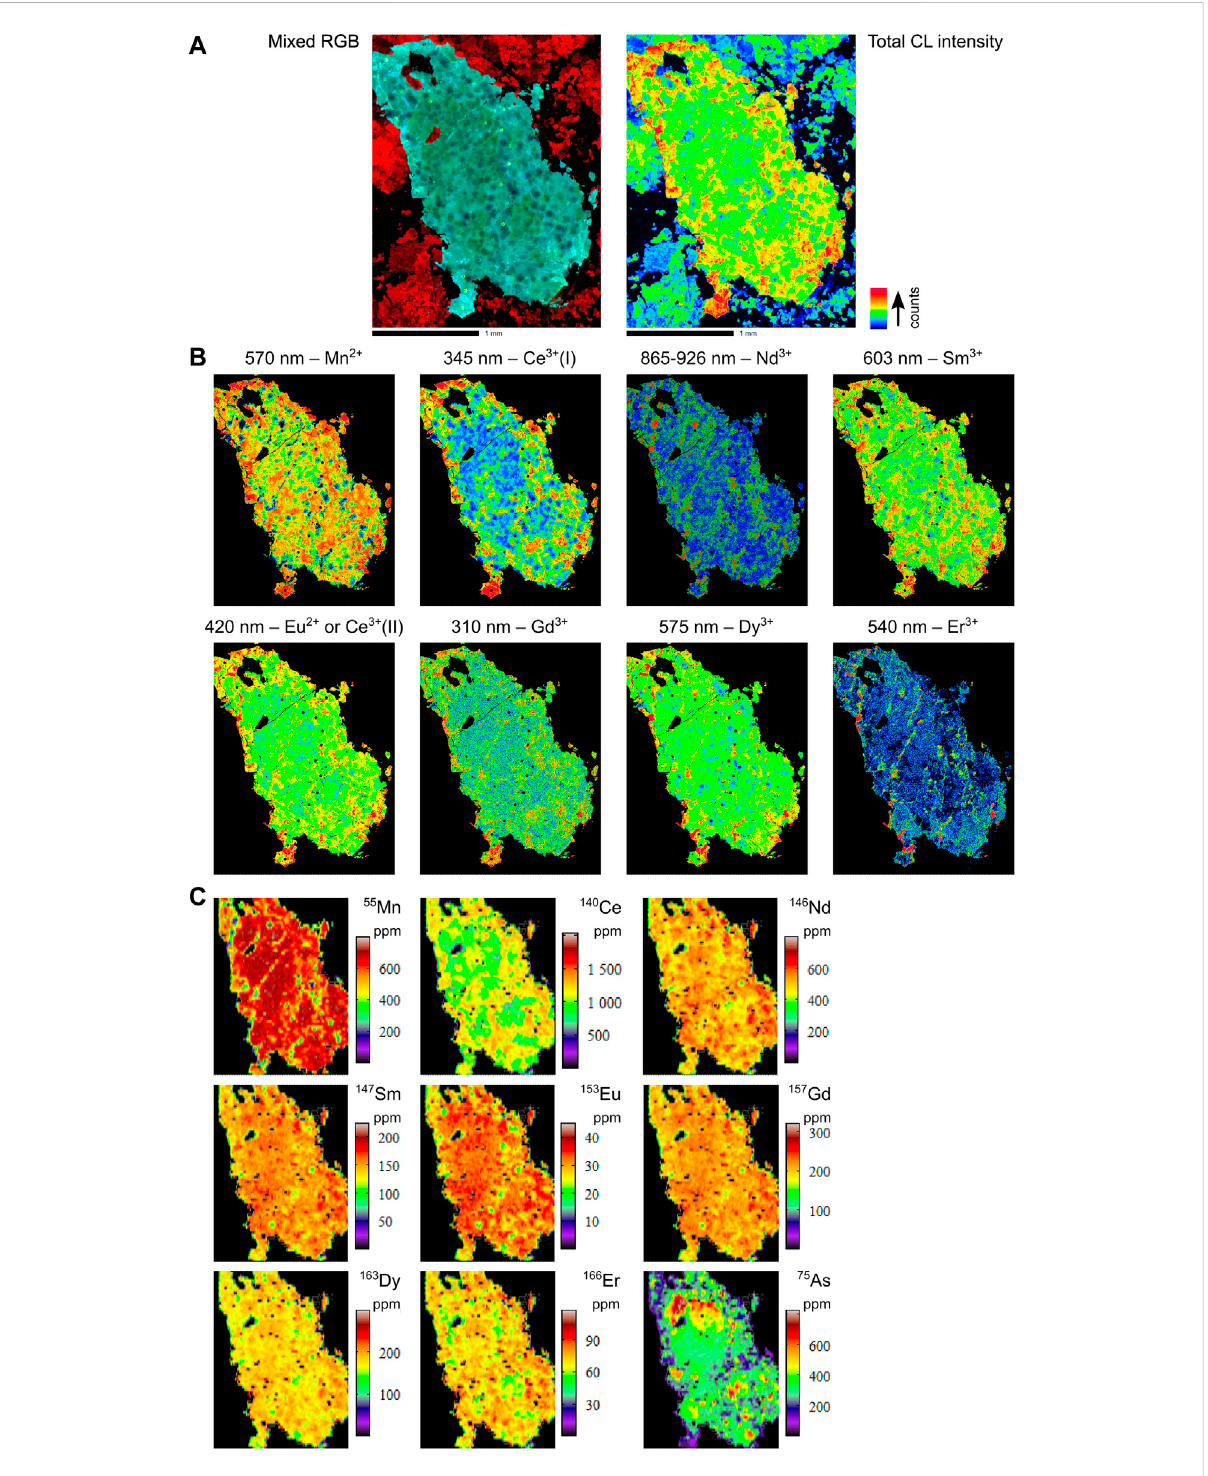
FIGURE 8 CombinedhyperspectralCLandLA-ICPMSimagesofselectedelementsforsampleEHM-005. (A) TotalCLintensityandmixedRGBimages. (B) Hyperspectral CL images. (C) LA-ICPMS